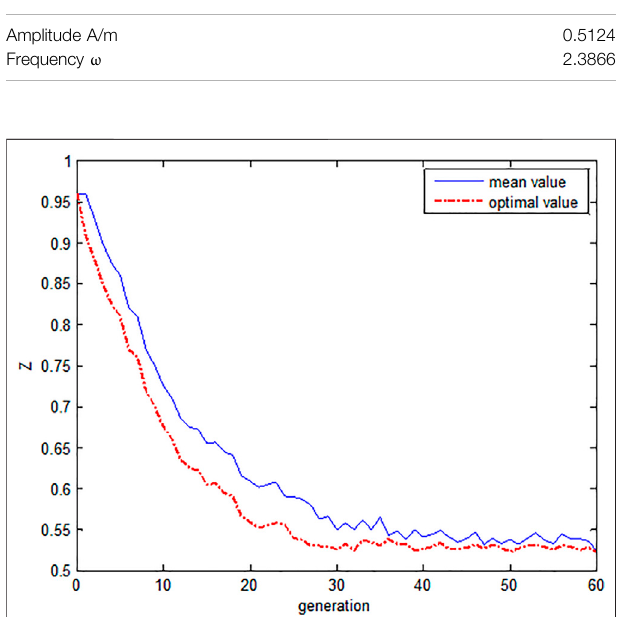
FIGURE 3 | Iterative process of the genetic